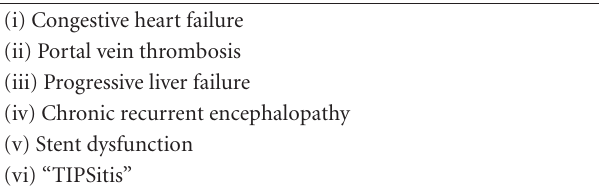
Table 3: Chronic complications after TIPS